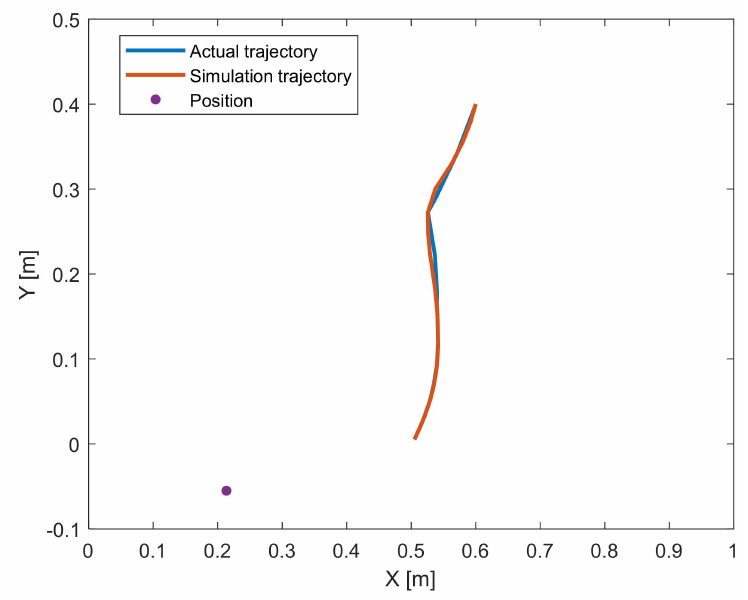
Figure 10. Trajectories of the proposed method implemented in the PID simulation and the actual robot duAro. Position indicates the origin of the robot arm (the first